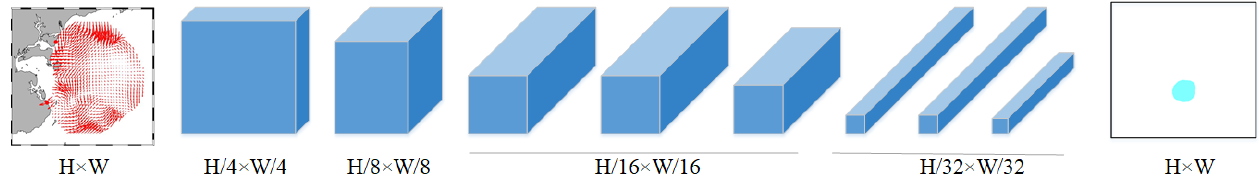
Figure 4. Cross-domain submesoscale eddy detection neural network (CDEDNet-0): Fundamental Architecture. The 8 blue cuboids correspond to 8 convolution layers. For each cuboid, the three dimensions are the height and width of its input image and the number of its output feature map. The leftmost map is the original current field. The rightmost map is the predicted eddy mask by CDEDNet-0.